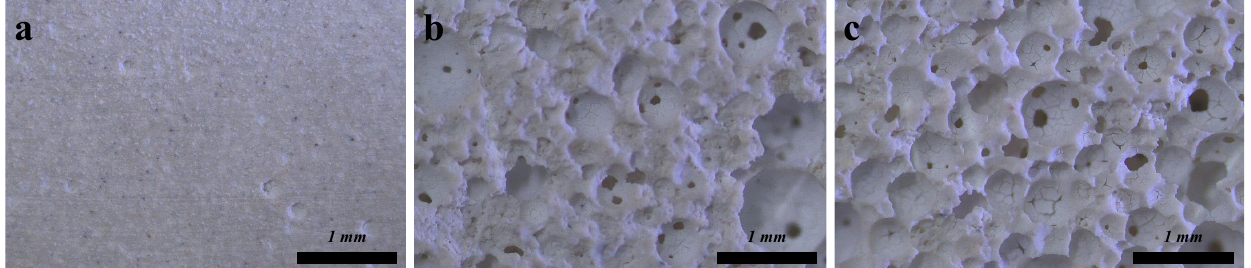
Figure 2. Macroscopic morphology of PPMOC1 ( a ), PPMOC3 ( b ), and PPMOC5 ( c ). The PPMOC number means different porosity (shown in the experimental section).